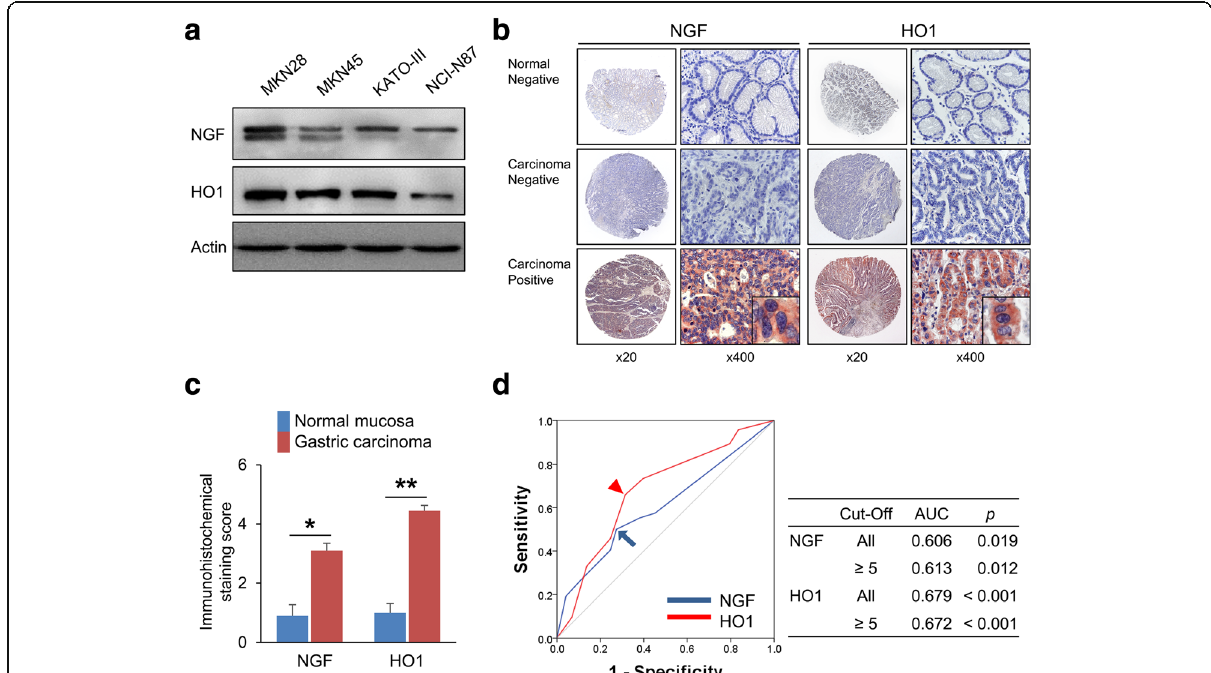
Fig. 1 The expression of NGF and HO1 in human gastric cancer cells and human gastric carcinoma tissue. a Validation of the anti-NGF and anti-HO1 antibodies used in this study. The expressions of NGF and HO1 were seen in western blotting analysis in four gastric cancer cell lines (MKN28, MKN45, KATO-III, and NCI-N8). b Immunohistochemical expression of NGF and HO1 in normal gastric mucosa and gastric carcinoma. Original magnification: low-power images; ×20, high-power images; ×400. c Immunohistochemical staining scores of NGF and HO1 in normal gastric mucosa and gastric carcinoma. *; p < 0.05, **; p < 0.001. d Statistical analysis for the determination of immunohistochemical positivity for NGF ( arrow ) and HO1 ( arrow head ). The cut-off points were determined by receiver operating characteristic curve analysis at the highest area under the curve value for